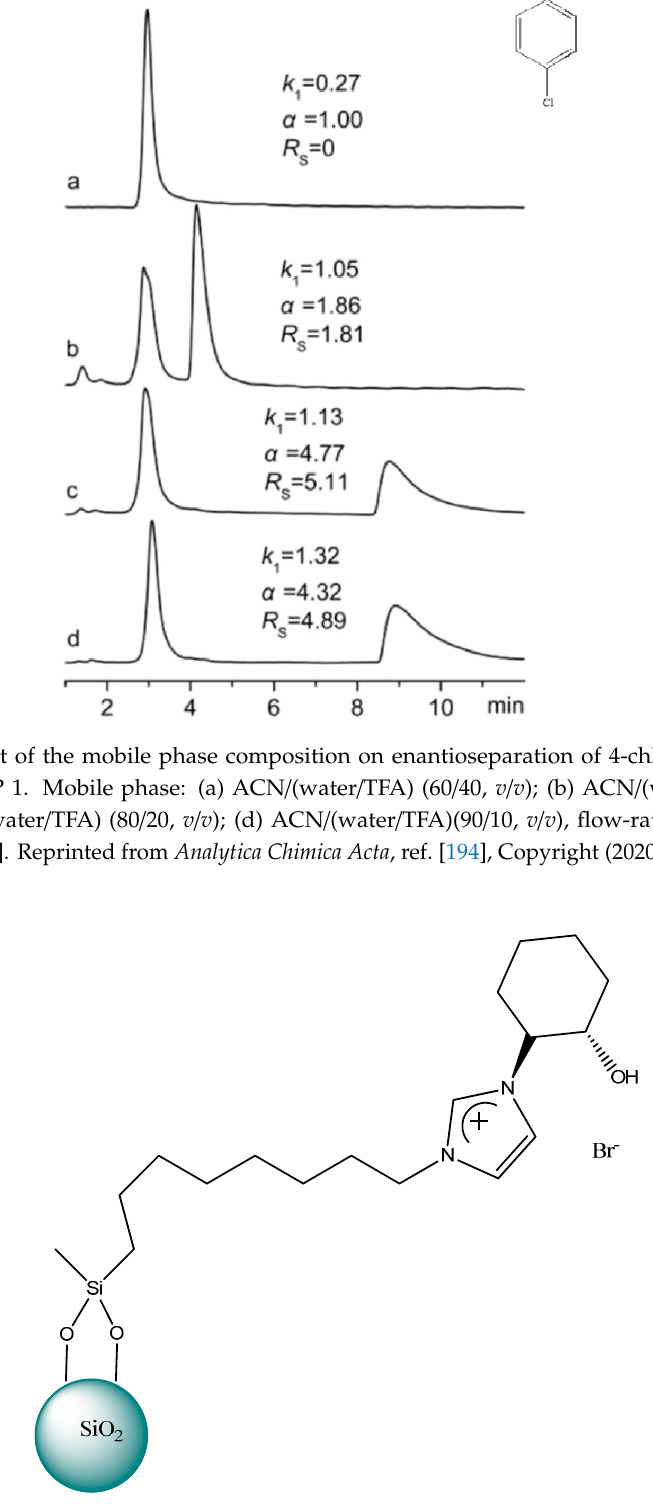
Figure 13. Chiral surface confined ionic liquid stationary phase (adapted from Kodali, 2014)